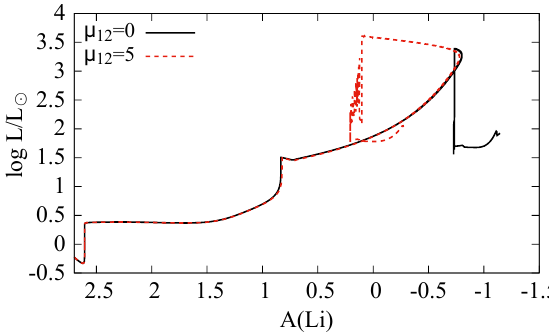
Figure 1. The luminosity L and the surface lithium abundance A (Li) of the models with µ 12 = 0 and